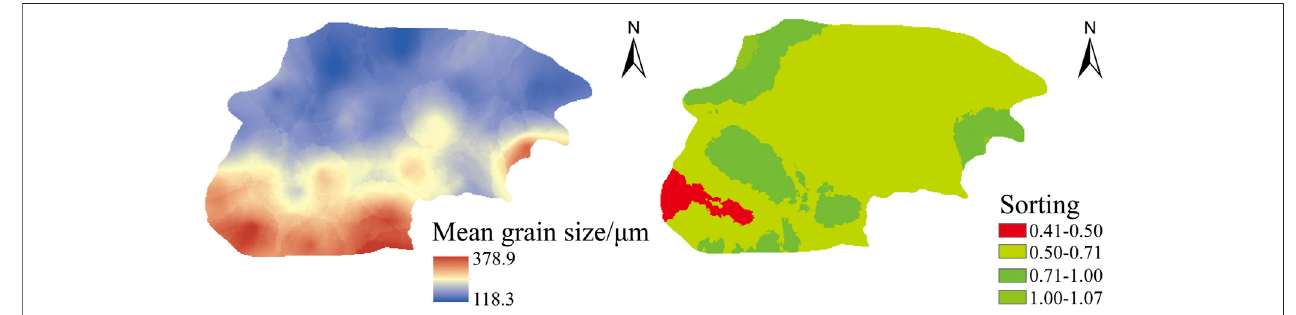
FIGURE 3 | Grain size parameters of sands in the Mu Us Sandy Land.